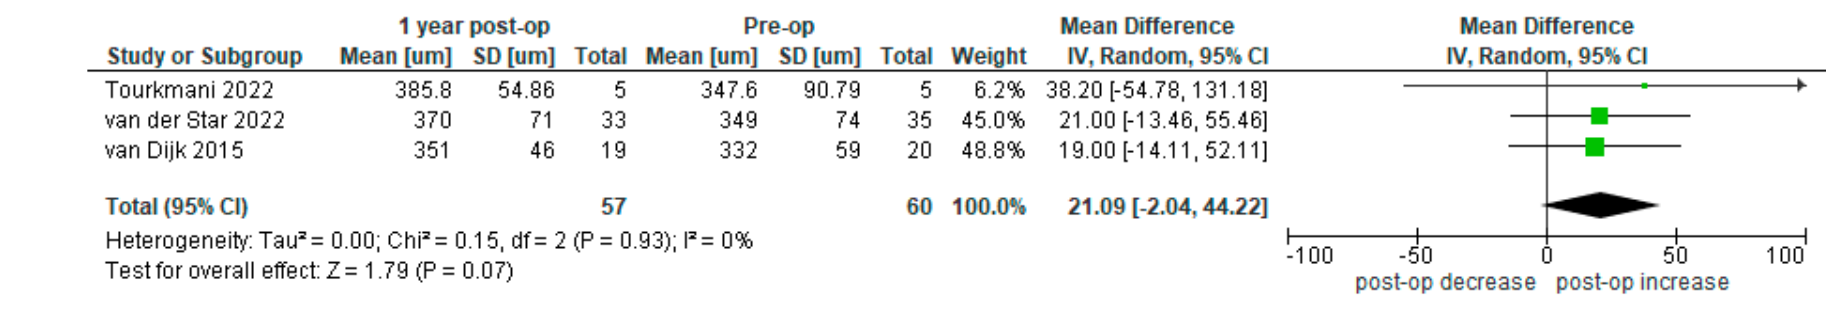
Figure A15. Di ff erence in pachymetry thinnest point across 3 studies [32,37,43].